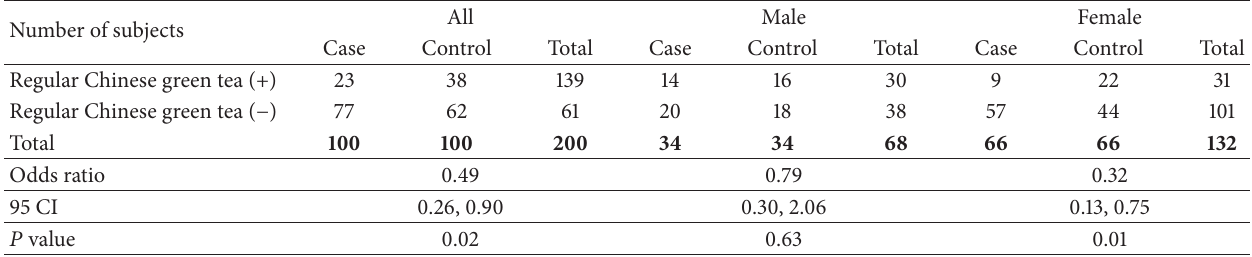
Table 3: Crude odds ratio of regular Chinese green tea consumption for diabetic retinopathy in the overall study participants and stratified by sex.